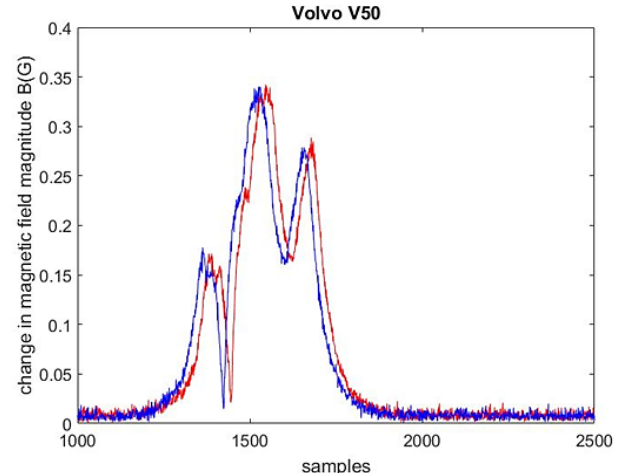
Figure 2. The change in magnetic field magnitude observed in two sensor nodes while a station wagon traveled at 102.9 km/h (sample delay equals 21 samples).